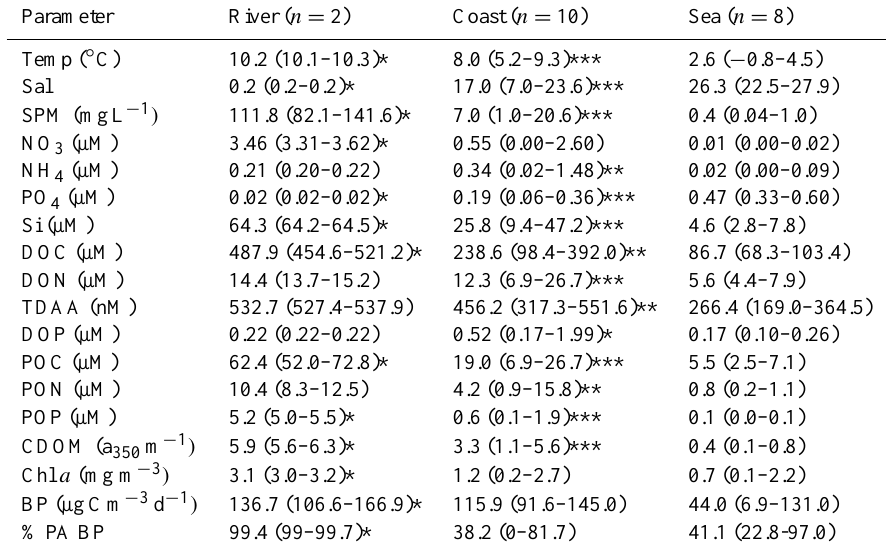
Table 1. Average and range of primary physical, chemical and biological parameters in the different sections of the study area. Temp: tem- perature. Sal: salinity. SPM: suspended particulate matter. NO 3 : nitrate concentration. NH 4 : ammonium concentration. PO 4 : phosphate con- centration. Si: silica concentration. DOC: dissolved organic carbon concentration. DON: dissolved organic nitrogen concentration.